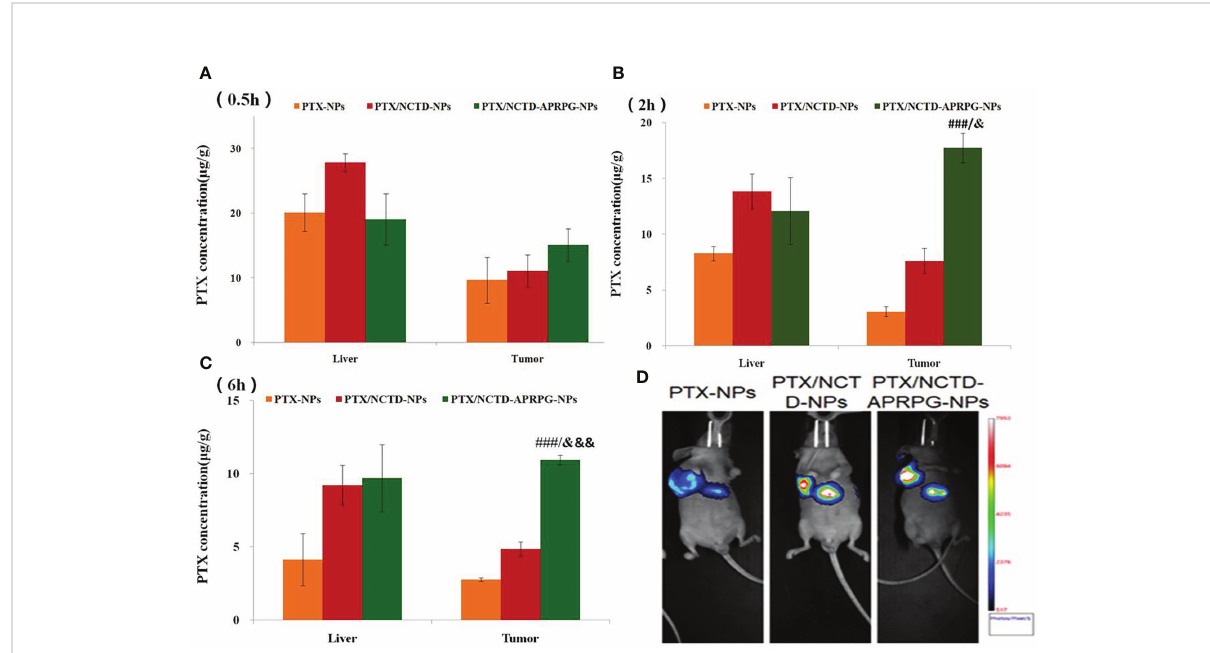
FIGURE 3 In vivo distribution of PTX in tumor-bearing mice treated with PTX-NPs, PTX/NCTD-NPs, and PTX/NCTD-APRPG-NPs. The experimental mice were randomly divided into three groups (PTX-NP, PTX/NCTD-NP, and PTX/NCTD-APRPG-NP groups) and injected with PTX-NPs, PTX/NCTD-NPs, or PTX/NCTD-APRPG-NPs at the dosage of 10 mg/kg. The tissue distribution of PTX was detected at 0.5, 2, and 6 h following injection. Bar graphs show PTX concentrations in various organs (heart, liver, spleen, lung, kidney, and stomach) and tumor tissues at (A) 0.5 h, (B) 2 h, and (C) 6 h after injection; ### p < 0.001 vs. PTX-NPs; & p < 0.05, &&& p < 0.001 vs. PTX/NCTD-NPs. (D) In vivo imaging assay to visualize the distribution of PTX in tumor-bearing mice treated with PTX-NPs, PTX/NCTD-NPs, and PTX/NCTD-APRPG-NPs. At 2 h after injection, the tissue distributions of PTX in the three experimental groups were imaged on the Bruker Small Animal Optical Imaging